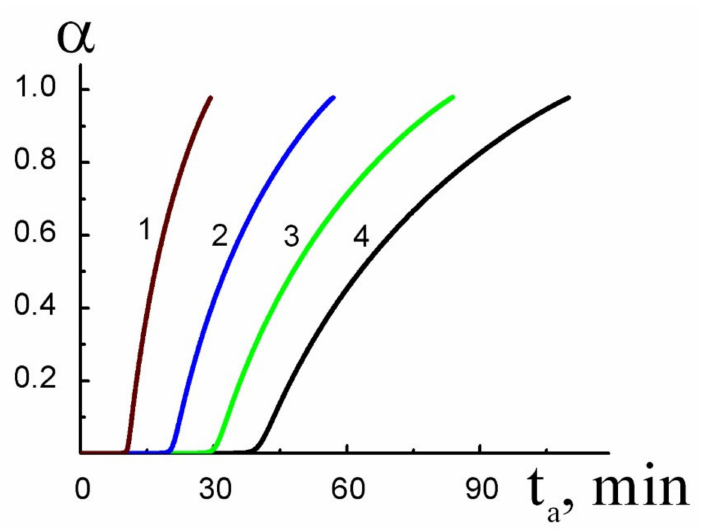
Figure 6. Numerical calculations of the depth of chemical transformations in the mechanically activated system Ti-N for different values of the parameter m ∑ ,0 : 1—0.00185, 2—0.0037, 3—0.0056, 4—0.0074.